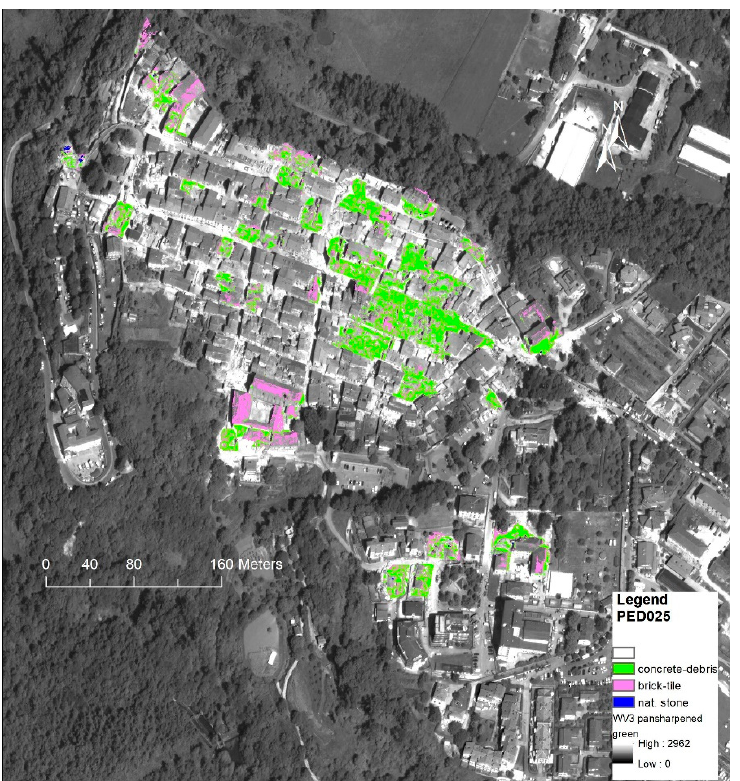
Figure 8 . Recoded PED distribution map of the three main categories at 0.25 PAM threshold. Table 4. Confusion matrices for the recoded PED maps obtained using the 0.25 PMA threshold (461 samples).